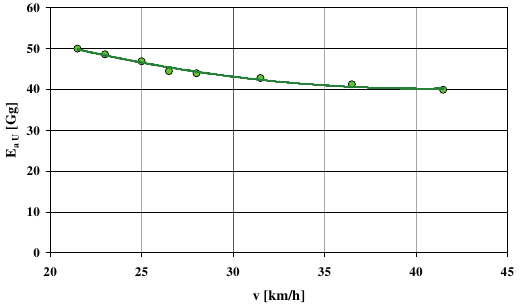
Fig. 4. Dependence of the national annual emission of volatile organic compounds from passenger cars upon the average velocity, under model conditions of urban